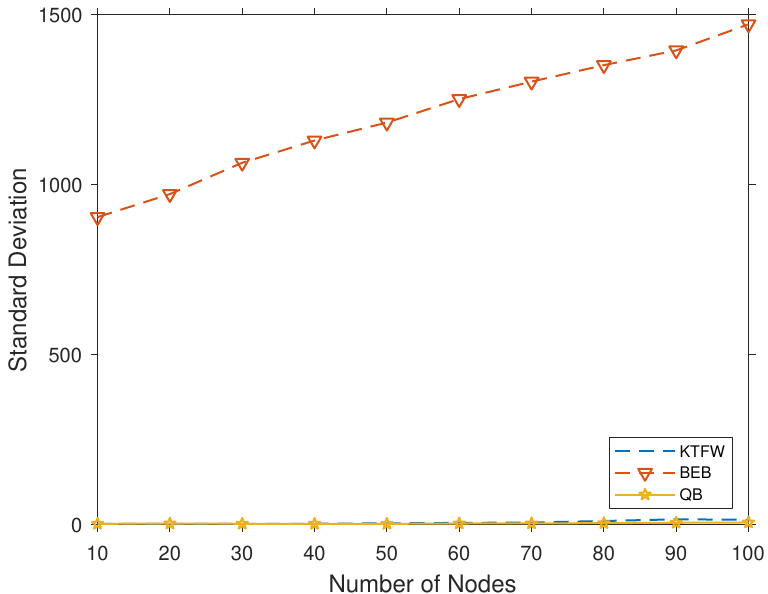
Figure 7. The standard deviation of the average packet latency for the three broadcast algorithms for 100 simulation runs and n ∈